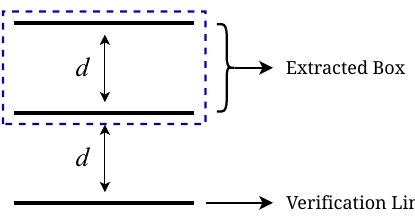
Figure 4. Extracting the bounding box of a parking space with a verification